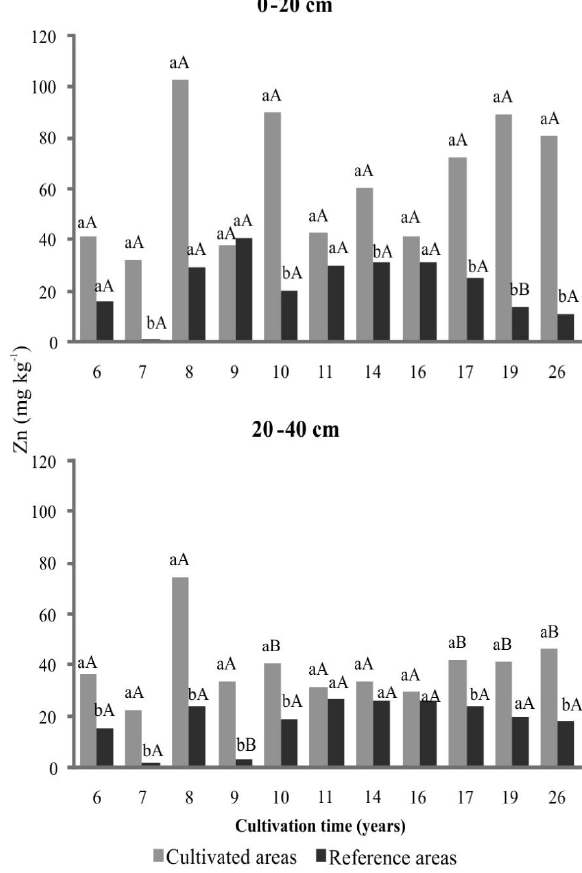
Figure 6. Total Zn contents in cultivated (CA) and reference areas (RA) in two layers (0-20 and 20- 40 cm) after different cultivation periods. Means followed by lowercase letters between environments (CA and RA) and capital letters between layers (0-20 and 20-40) did not differ statistically by Tukey’s test (p (cid:172)(cid:31)(cid:172) 0.05).